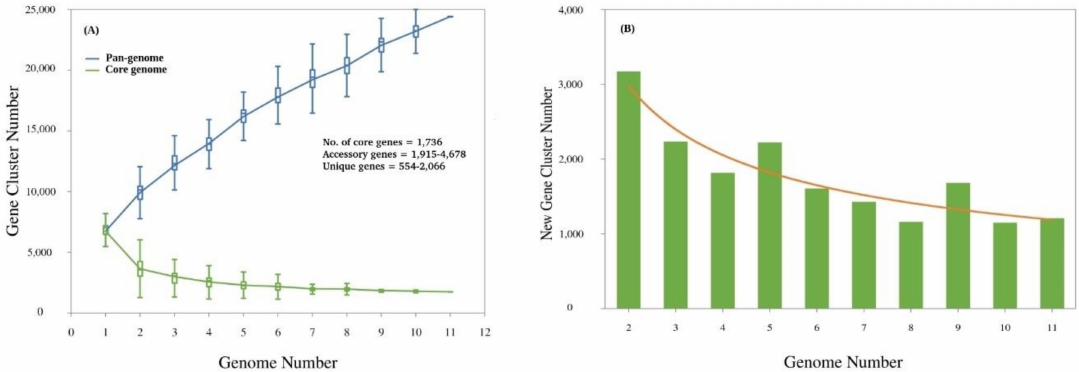
Figure 3. The pan-genome of Streptacidiphilus based on 11 species. ( A ) Core vs. pan developmental plot of eleven Streptacidiphilus genomes. The blue line indicates an increase in the number of genes in a pan-genome on sequential addition of genomes, and suggests an open pan-genome for this genus. In contrast, the number of core genes shared across these genomes decreases with the sequential addition of genomes, indicated by the red line. ( B ) Plot representing the number of new unique genes as a function of the number of strains added